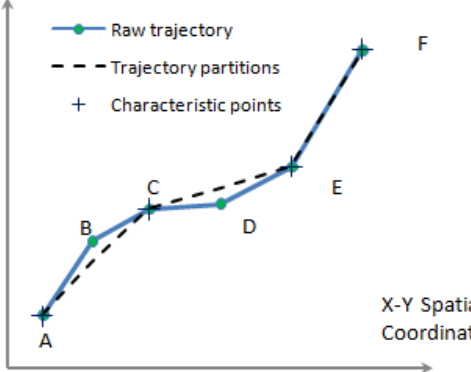
Figure 1. An example of trajectory